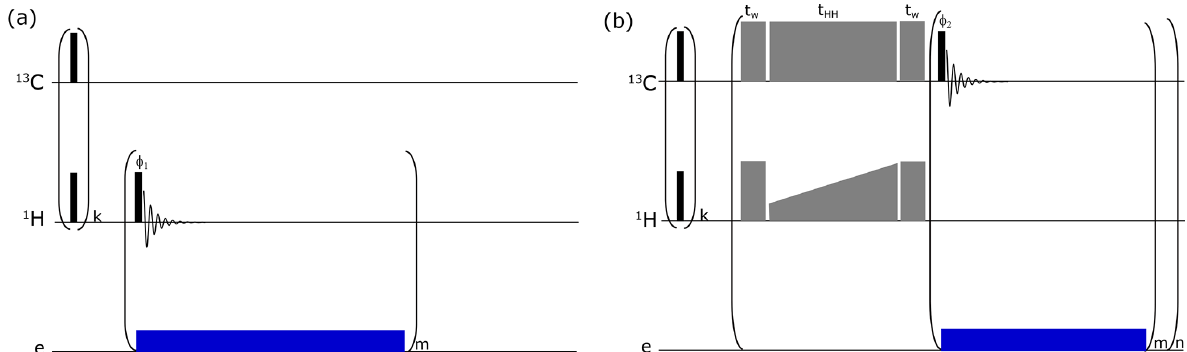
Figure B1. Pulse sequence used to monitor (a) 1 H DNP buildups and (b) solid-state DNP pulse sequence via cross-polarization (CP) for d-DNP. A train ( k = 64) of π/ 2 pulses was applied to both RF channels for pre-saturation. For 1 H buildup measurements, a small-flip-angle radio frequency (RF) pulse is employed after each µw irradiation of 10s (depicted as “blue” block) to monitor the polarization level. Here CP (depicted as “grey” blocks) is performed using adiabatic half-passage pulses ( t w = 175µs) to convert longitudinal magnetization into transverse magnetization before the start of the contact pulse ( t HH = 15ms) and vice versa after the contact. Contact pulses use RF powers of 15W on 1 H (using rectangular pulse with constant RF amplitudes of 21kHz) and 60W on 13 C (using ramped up pulse with linearly increasing RF amplitudes from 16 to 23.2kHz). In total, 16 CP contacts ( n = 16) are made. For each contact, a sequence of m = 4 pulses with low-flip-angle pulse (5 ◦ ) is applied on the 13 C channel to monitor the buildup of the polarization from 1 H to 13 C. Microwave irradiation is selectively switched on after each CP contact for 80s to improve DNP polarization efficiency by avoiding the significant contribution of electron spin in the nuclear spin relaxation rate.